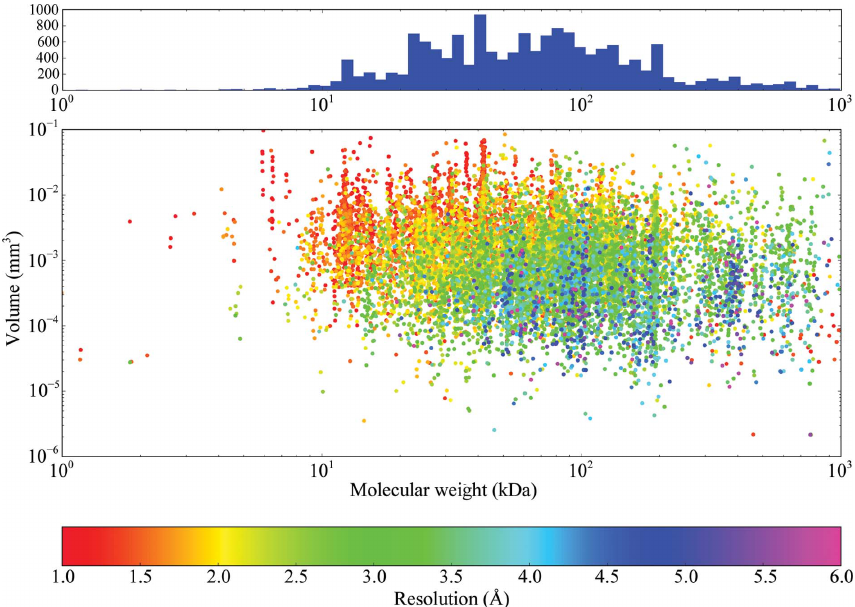
Figure 7 The relationship between crystal volume, molecular weight and obtained resolution. The crystal volume is plotted against the molecular weight of the entity crystallized coloured by the highest resolution cutoff from autoprocessing; note the logarithmic scales for volume and molecular weight. The histogram shows the distribution of molecular weight in the scatter plot. N = 15